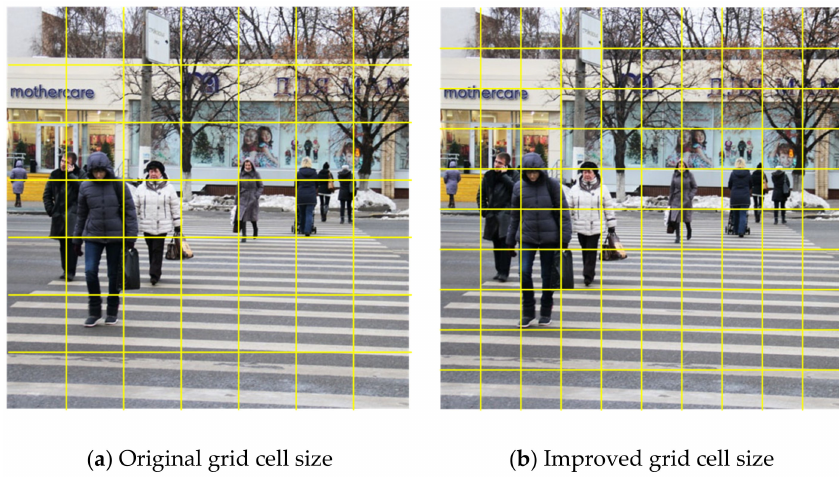
Figure 2. An example picture of improved grid cell